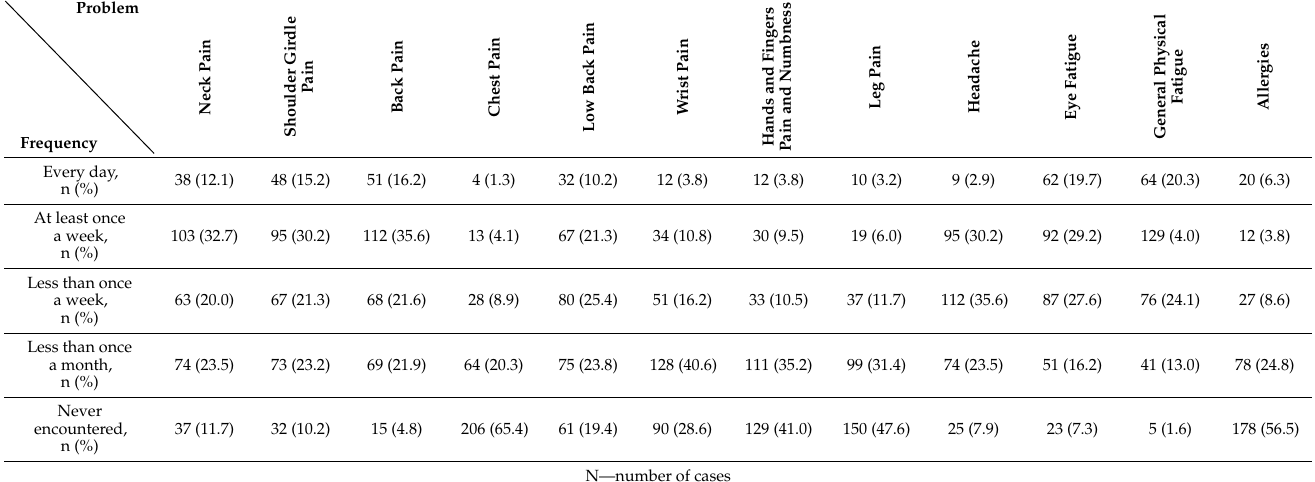
Table 1. Frequency of pain and ailments experienced by dentists and orthodontists during and after